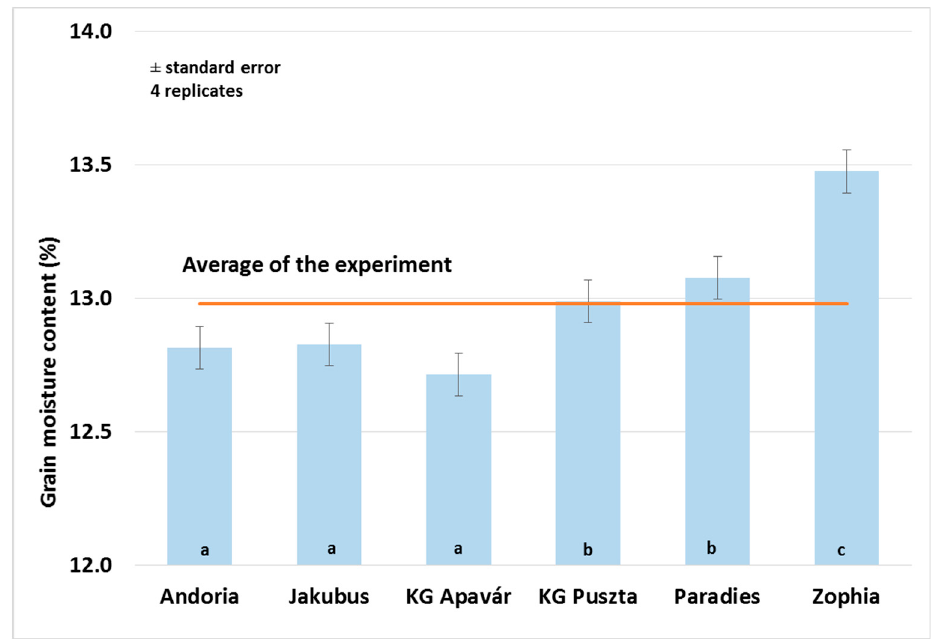
Figure 10. Grain moisture content of winter barley cultivars, average of N treatments (Debrecen, 2020). Standard error of means, 4 replicates. Means are compared to the average of the experiment. All varieties had adequately low grain moisture content to the storage. The differences in grain moisture content were statistically significant among the varieties. Different letters mean statistically significant difference ( p < 0.05).